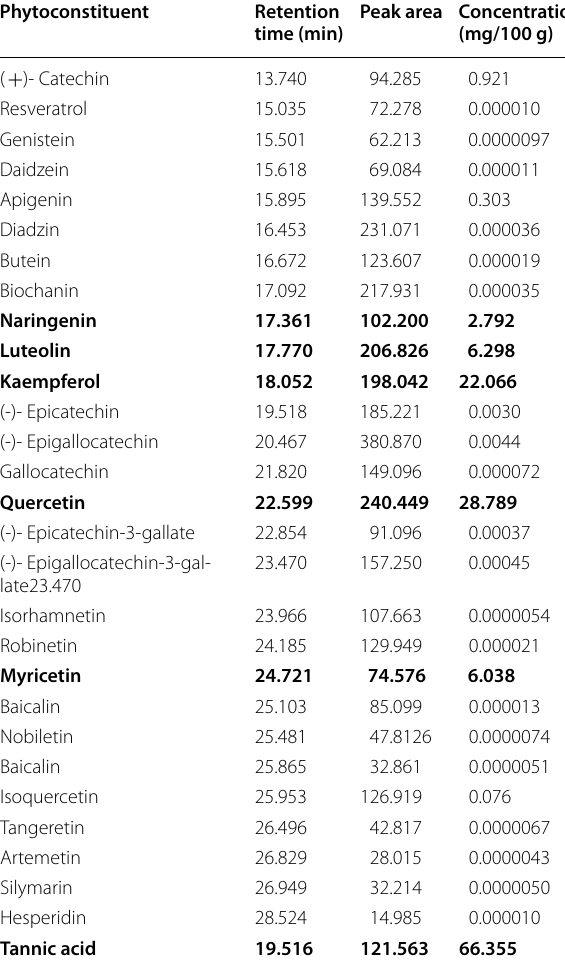
Bold values dennotes the ones in high concentrations in the extracts